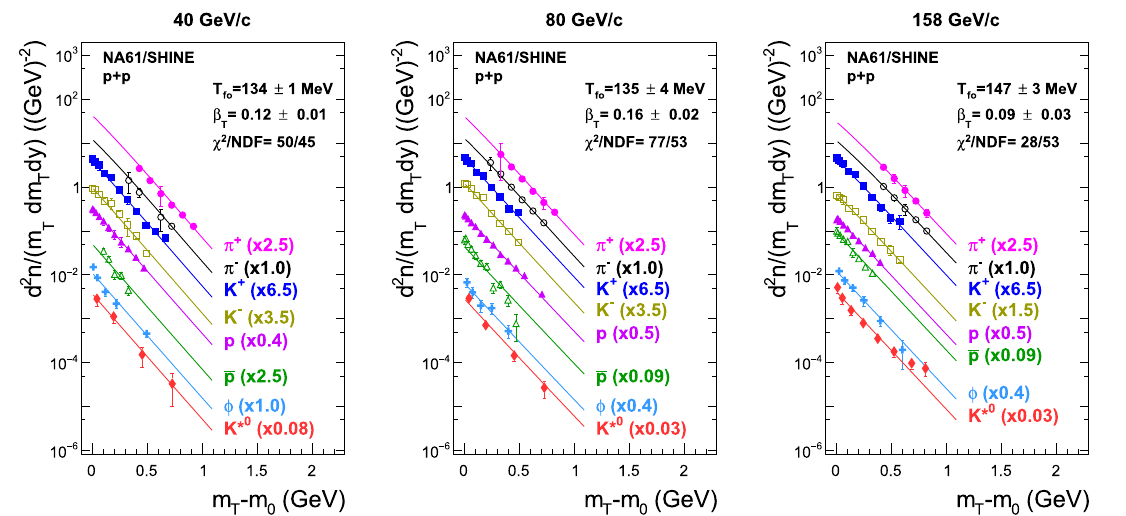
Fig. 14 The transverse mass spectra of K ∗ ( 892 ) 0 mesons (0 < y < 1 . 5 for 40 and 80 GeV / c from this analysis, and 0 < y < 0 . 5 for 158 GeV / c from Ref. [9]) and other hadrons previously measured by NA61/SHINE(chargedpions,chargedkaons,protons,anti-protons[40] in 0 < y < 0 . 2, and φ mesons [41] in 0 < y < 0 . 3; for π − at 80 GeV / c the rapidity range 0 . 2 < y < 0 . 4 was used instead of 0 < y < 0 . 2) fit-